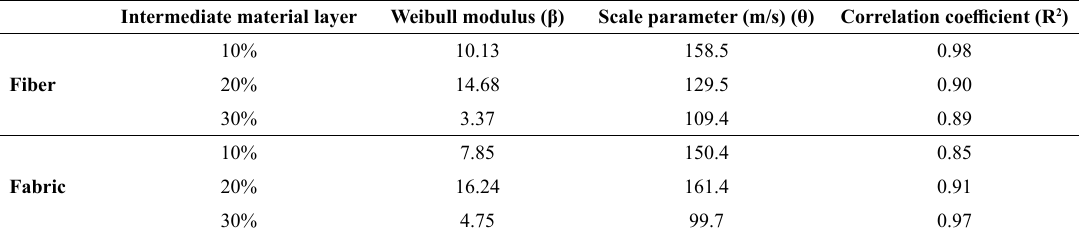
Table 3. Weibull statistical parameters for the value of E fractions of both fique fibers and